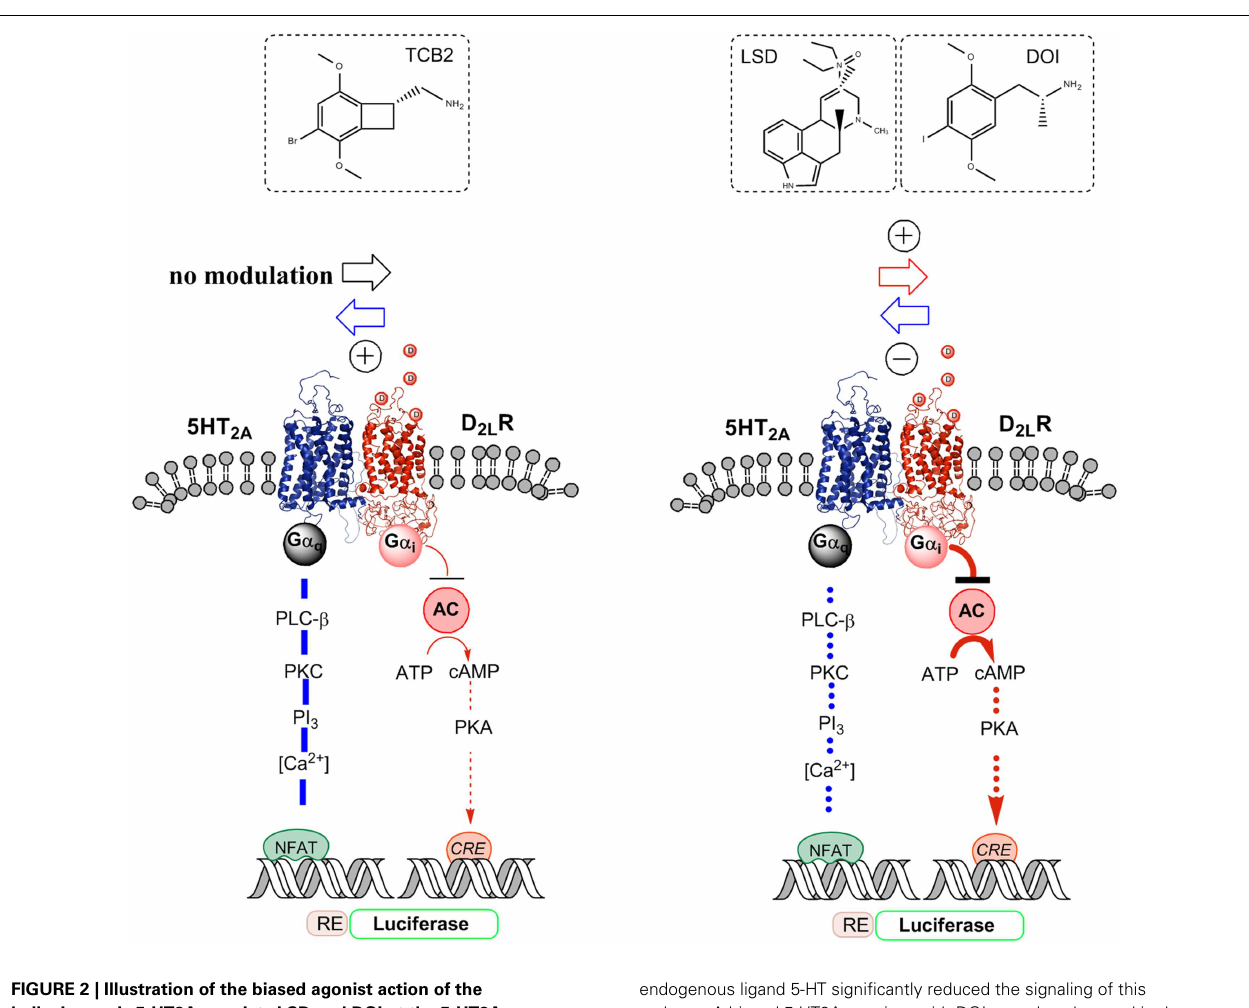
FIGURE 2 | Illustration of the biased agonist action of the hallucinogenic 5-HT2A agonists LSD and DOI at the 5-HT2A protomer of the 5-HT2A–D2LR heterodimer, which leads to enhanced Gi/o signaling over the D2R protomer producing an enhanced inhibition of theAC–PKA–CREB pathway . In contrast, the standard 5-HT2A agonistTCB2 did not produce a modulation of the D2R agonist-induced inhibition of the AC–PKA–CREB pathway and the